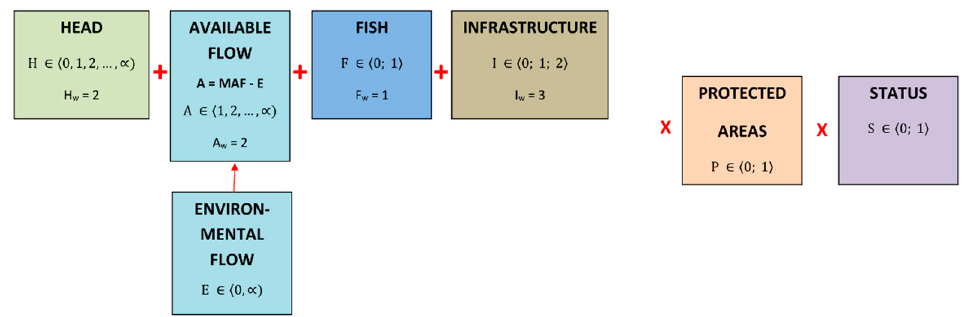
Figure 3. Diagram of the product compute the HAFIPES value.